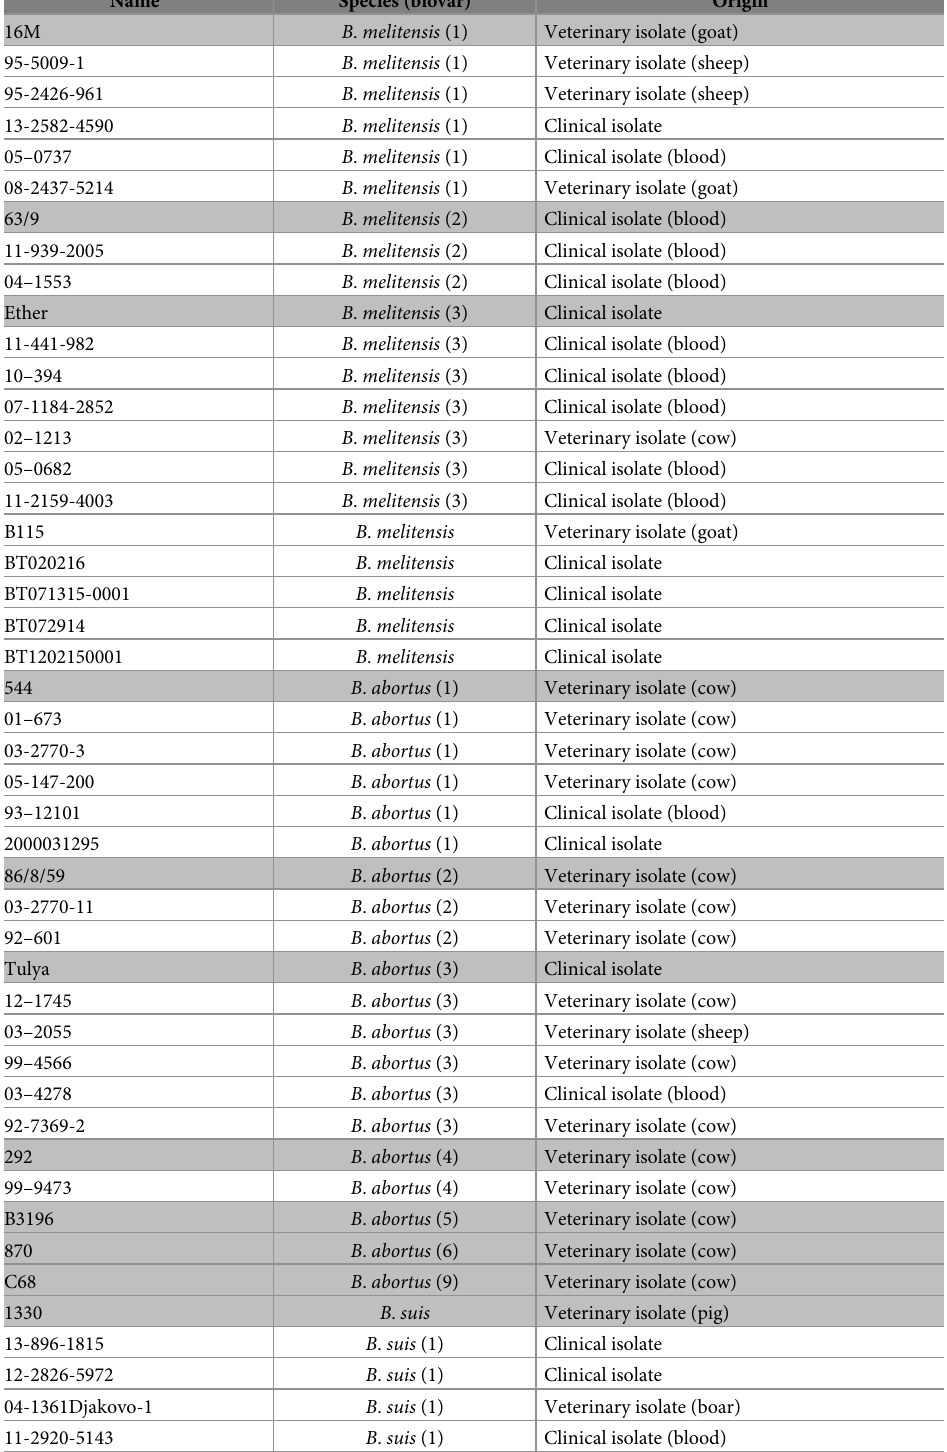
Table 1. Brucella strains and isolates retained to generate the MALDI-TOF MS database. Strains highlighted in grey are reference or type